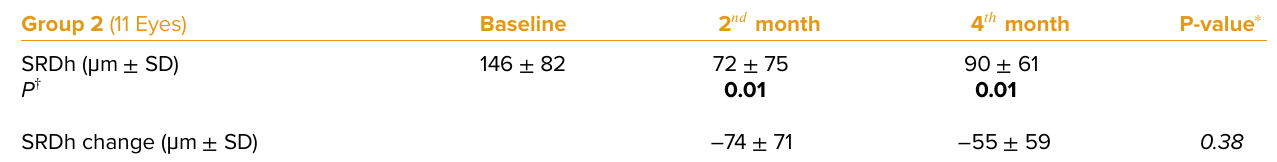
Table 4. Serous Retinal Detachment height changes over follow-up Group 2 (11 Eyes)